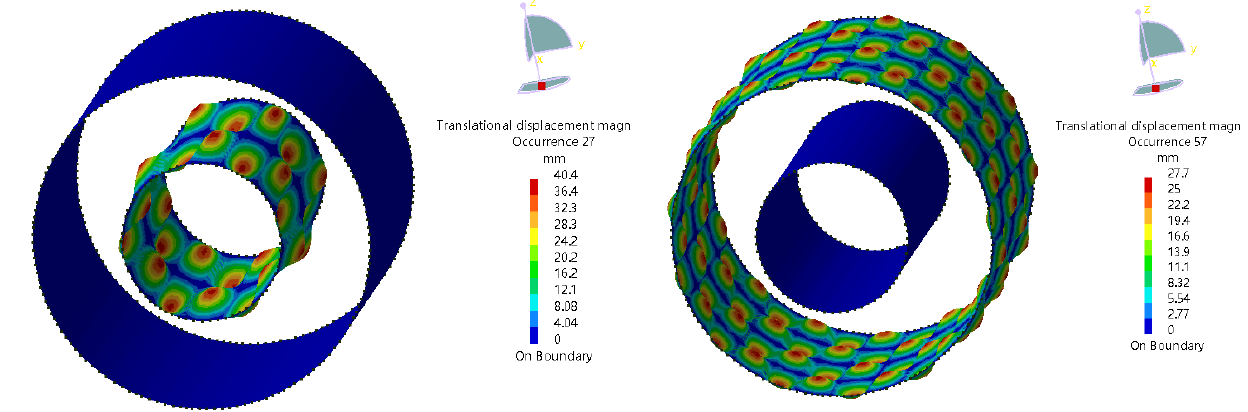
Figure 10. Structural modal vibration shapes of oil and casing pipe (20,000.6 Hz). The sound pressure distribution in the annulus region and inside the oil pipe at different frequencies is shown in Figure 11. Since the sound pressure in the annulus region is much higher than that inside the oil pipe, the sound pressure distribution in the oil pipe shows no obvious change in the sound pressure diagram. Figure 12 shows the SPL distribution. It can be seen that the sound pressure at the position (inside the oil pipe) directly facing the leakage hole is higher than that at other positions. Consequently, the ultrasonic testing equipment can detect the leakage sound field signal more easily when placed in this position.